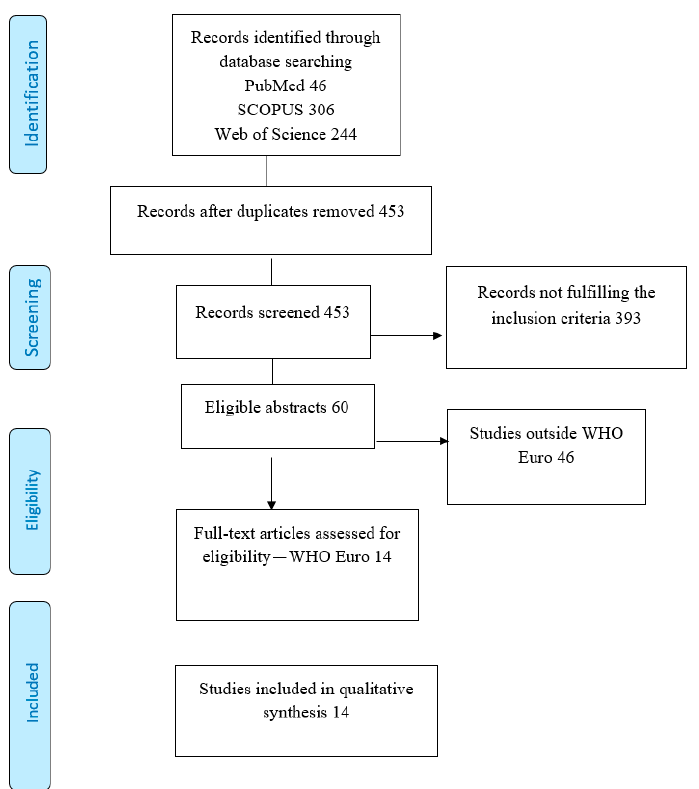
Figure 1. Preferred Reporting Items for Systematic Reviews and Meta-Analyses (PRISMA) flowchart of the literature search.